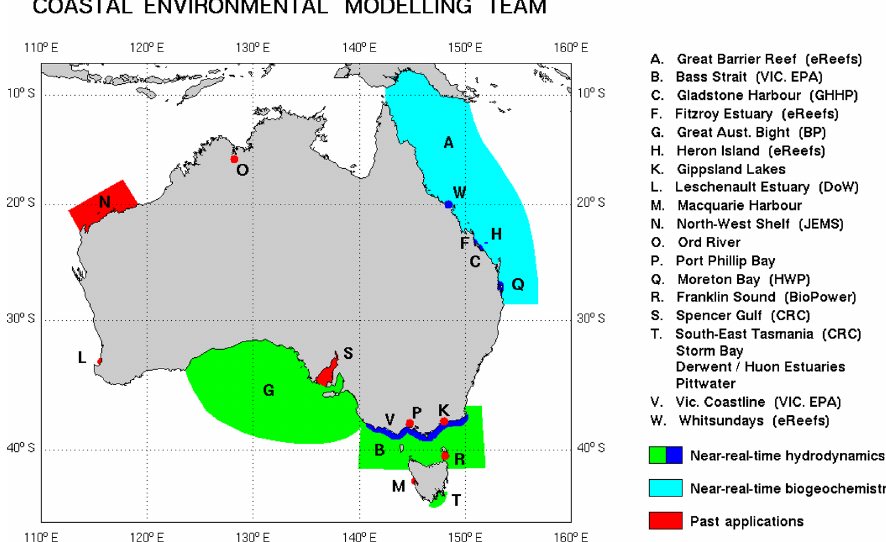
Figure 1. Model domains of the CSIRO EMS hydrodynamic and biogeochemical applications from 1996 onwards. Additionally, EMS was used for the nationwide Simple Estuarine Response Model (SERM) that was applied generically around Australia’s 1000 + estuaries (Baird et al., 2003). Brackets refer to specific funding bodies. EMS has also been applied in the Los Lagos region of Chile. A full list of past and current applications and funding bodies is available at https://research.csiro.au/cem/projects/ (last access: 22 September 2020).